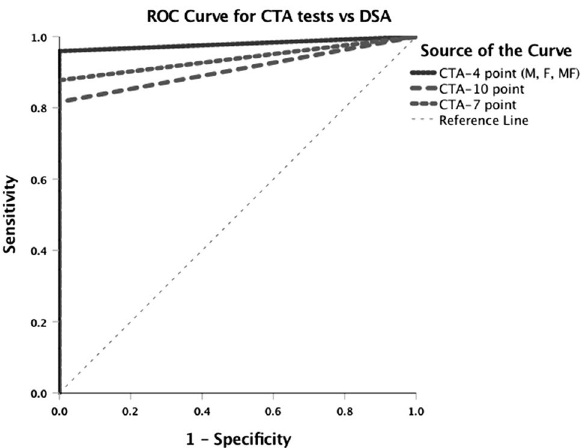
Figure 3. Receiver-operating characteristic curve shows the diagnostic accuracy of all computed tomography angiography (CTA) tests compared to Digital Subtraction Angiography (DSA) for determination of brain death.